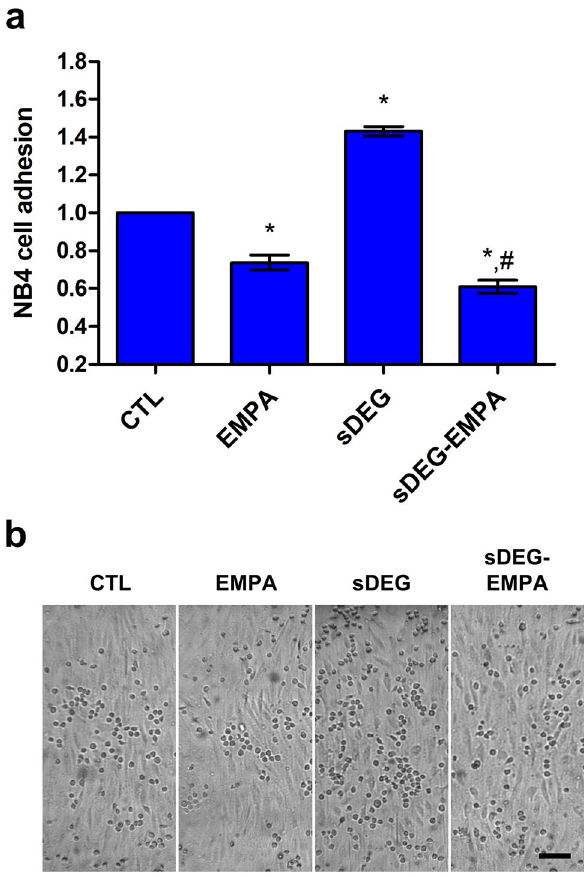
Figure 1. NB4 cell adhesion assay following shear culture for 24 h. ( a ) Relative numbers of NB4 cell adhesions to TNF-α stimulated ECs under sustained HS degradation with or without EMPA treatment. Degradation caused increases in adhesion compared to control (sDEG vs CTL *p < 0.001). EMPA reduced the adhesion compared to control (EMPA vs CTL *p < 0.001) and prevented the increase caused by degradation (sDEG- EMPA vs sDEG # p < 0.001) resulting in adhesion levels below control (sDEG-EMPA vs CTL *p < 0.001). ( b ) Representative images of each condition (scale bar = 100